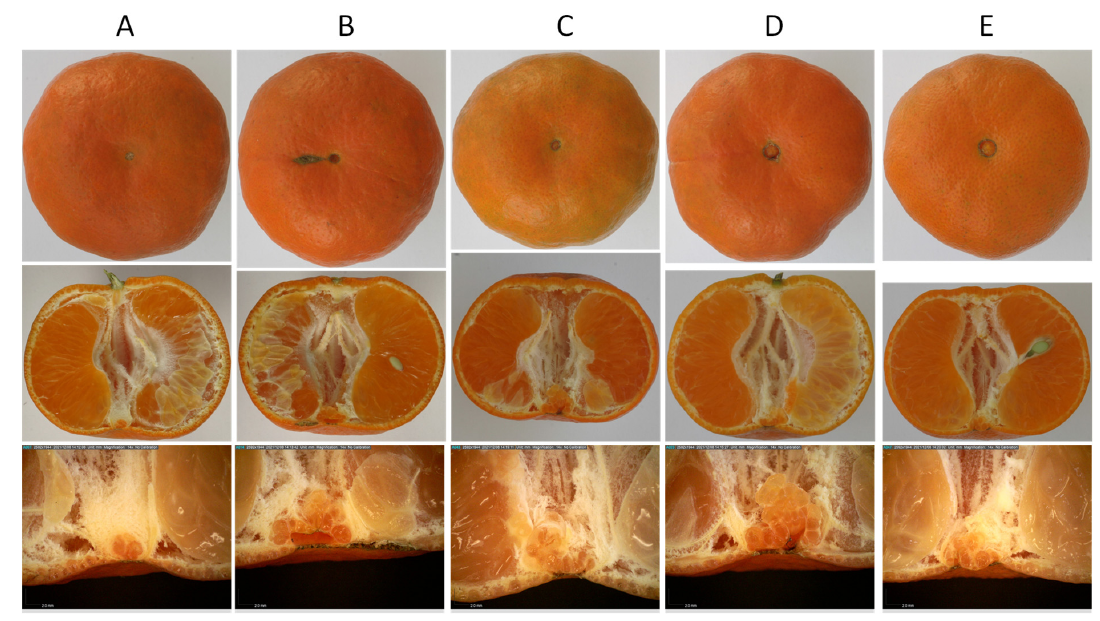
Figure 2. Variability in stylar end morphology in ‘Dancy’ mandarin fruits. The large and morpho- logically complex navel ends in some fruits are mechanically weaker and subject to greater risk of PFS. ( A ) small stylar end scar on the outside (( A ), top), with simple internal morphology (( A ), middle, bottom). ( B – E ). Different examples of larger stylar ends with greater complexity and greater risk of PFS. The micrographs of the stylar ends were taken with a Dino-lite camera AM4117MZT (https://www.dino-lite.com/ (accessed on 22 June 2022)).